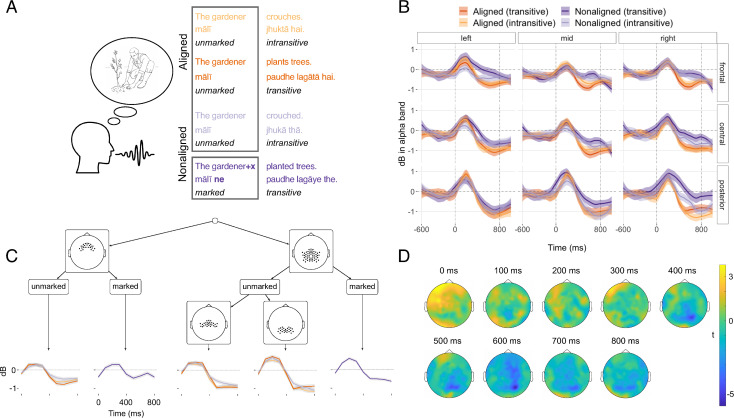
(A) Illustration of the contrast between unmarked and marked noun phrases (which crosses over aligned and nonaligned expressions) in Hindi: Aligned expressions are always unmarked (“The gardener…”), as are nonaligned noun phrases in intransitive sentences (“The gardener crouched”), while nonaligned noun phrases in transitive sentences are marked (“The gardener+x planted trees”). (B) Smoothed grand averages of event-related power changes (dB relative to a baseline period of −600 to −200 ms) in individually defined alpha frequency bands. (C) Regression model tree for power changes in individually defined alpha frequency bands between 0 and 800 ms. The model also identified lower-order splits which are subsidiary to the main difference between marked and unmarked expression (see S5 Fig, S6 Table). (D) Topographic maps of power differences (in t-values) between sentences with marked unmarked expressions for a fixed alpha frequency band (8–12 Hz). (A–D) All other conventions are identical to the conventions in Fig 2. (Underlying data and scripts are available from https://osf.io/uhtcn/ and in the Supporting information file S1 Data.) Overall, the planning of sentences with unmarked expression (intransitive and transitive aligned sentences and intransitive nonaligned sentences) reveals ERD (more negative dB) in the alpha band. ERD, event-related desynchronization.